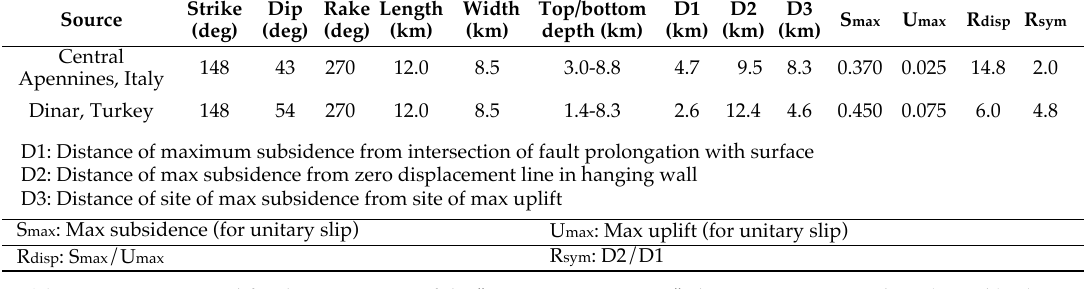
Table 2 . Parameters used for the comparison of the "coseismic signatures" shown in Fig. 2 E-F. (see also Table